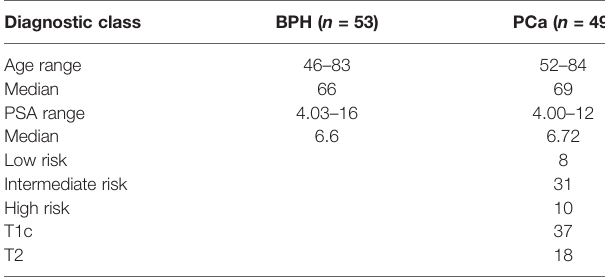
TABLE 1 | Patient